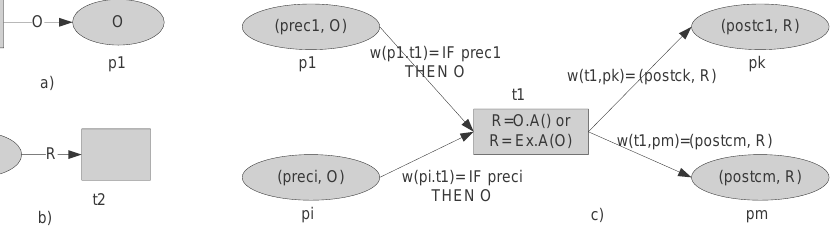
Fig. 6. Presentation of TFM elements with CPN constructs.